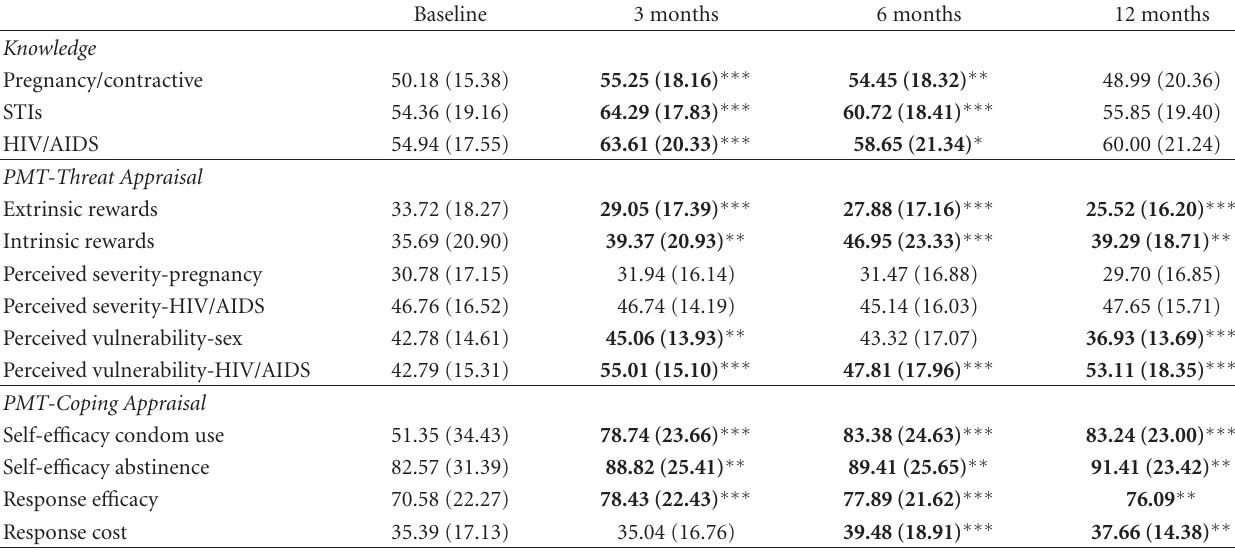
Table 3: Standard mean scores (with standard deviation) (range 0–100) for knowledge and PMT constructions at baseline and follow-ups for EWA a